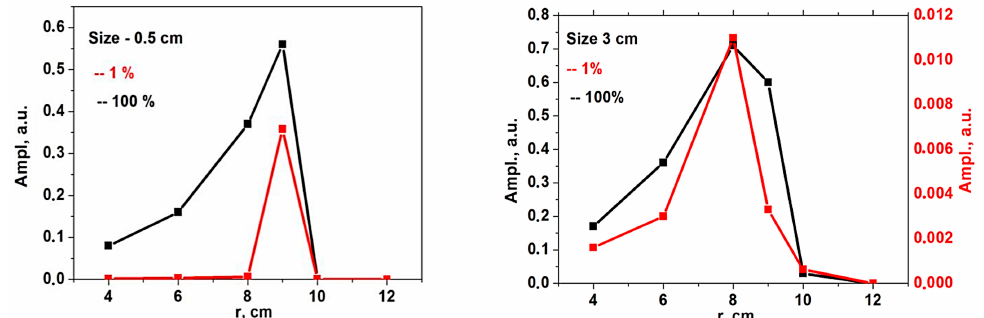
Figure 10. The dependency of the signal amplitude on the radial position of the circular filament of ( left ) 0.5 cm diameter and ( right ) 3 cm diameter. The red line corresponds to the filament with an amplitude of 1% of density at cutoff of the probing wave 48 GHz where the filament was positioned, and the black line corresponds to an amplitude of 100%.